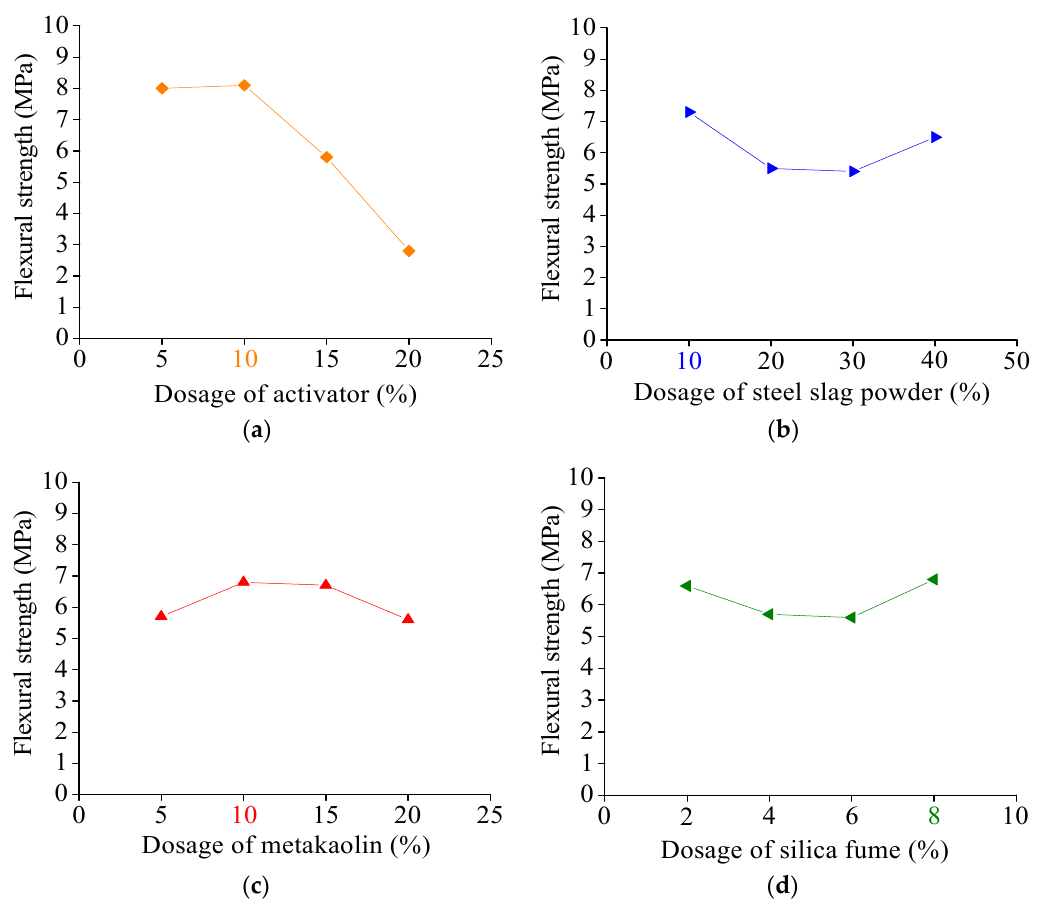
Figure 6. Relationship between flexural strength and dosage levels of each factor: ( a ) activator; ( b ) steel slag powder; ( c ) metakaolin and ( d ) Silica fume.